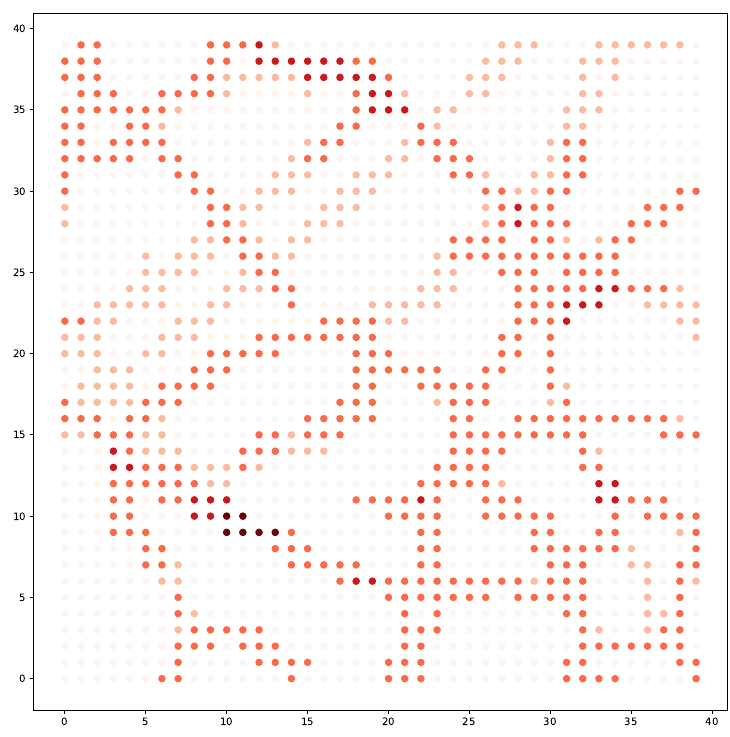
Figure 4. A snapshot of the event intensities in the